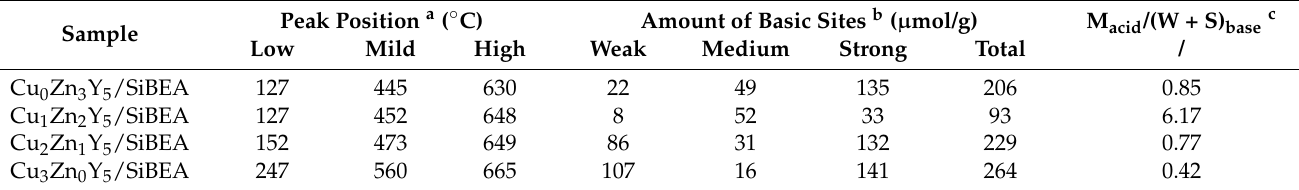
Table 3. The basicity and acid/base ratio of the fresh CuZnY/SiBEA